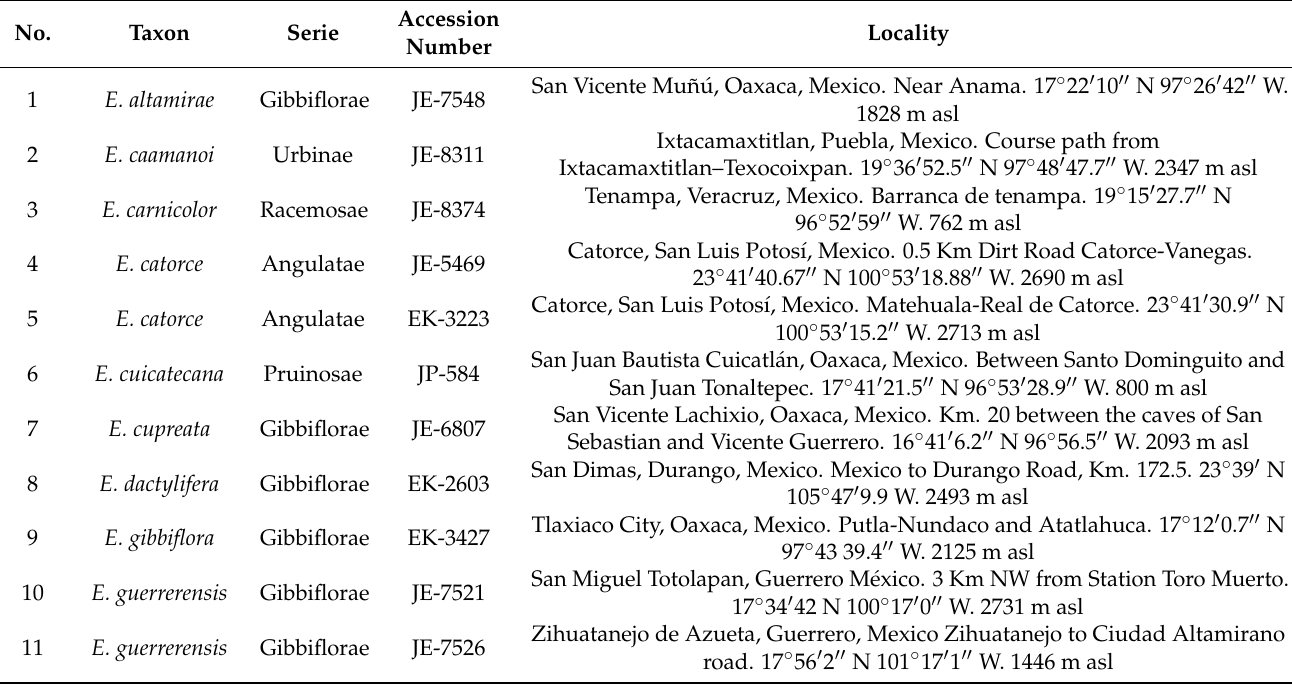
Table 1. Provenance of Echeveria species and populations examined in this